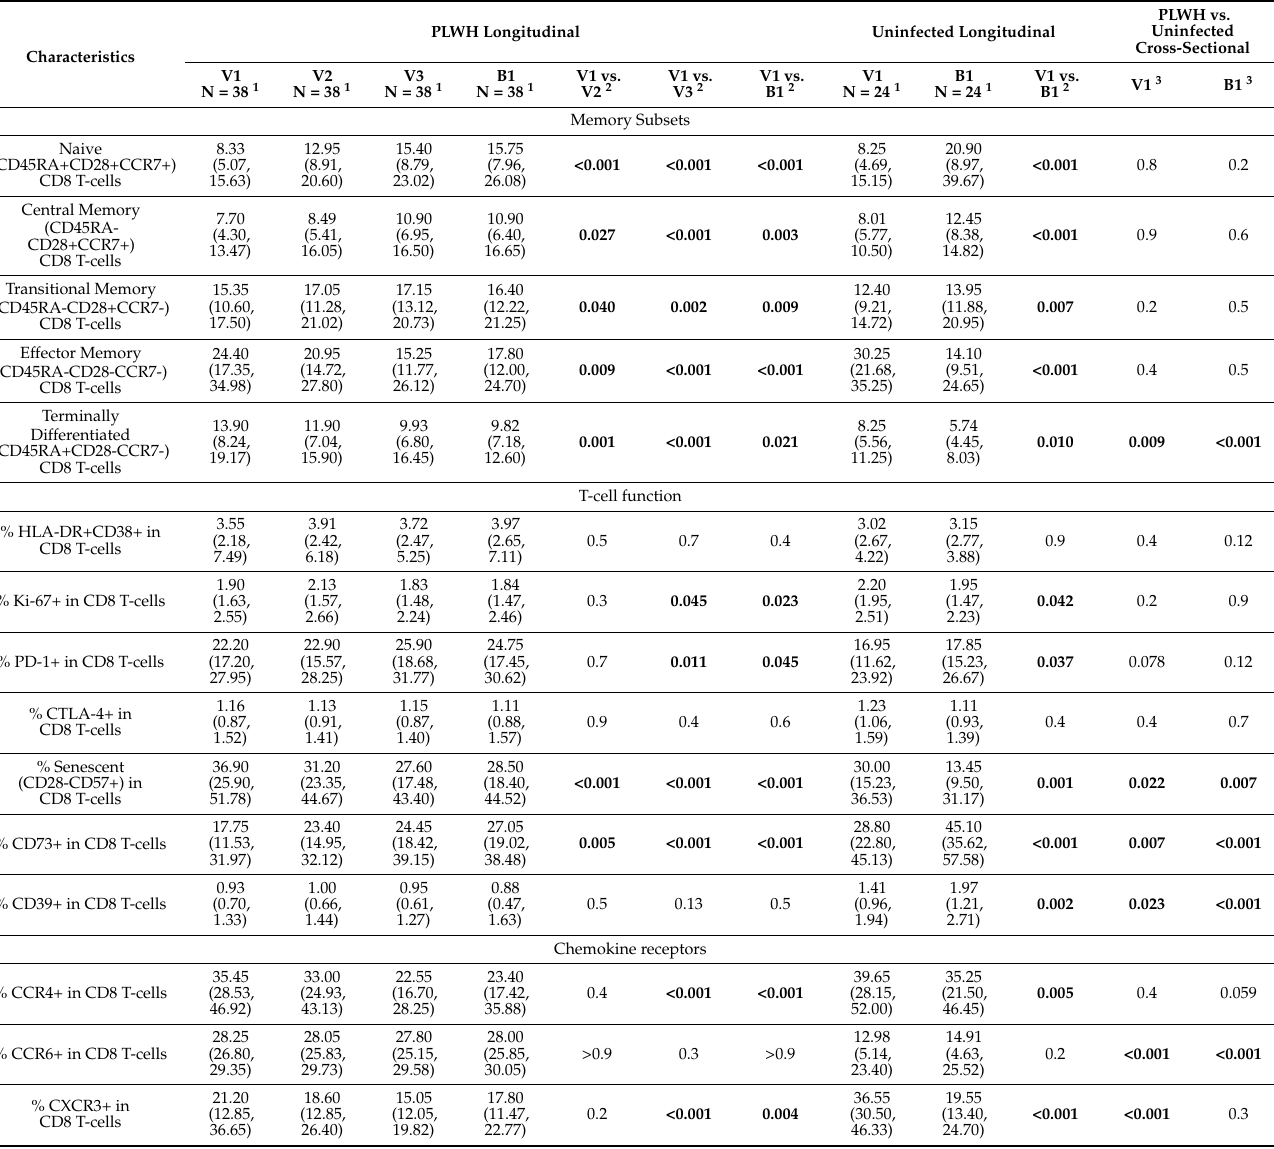
Table 3. Changes in the frequencies of CD8 T-cell subsets following SARS-CoV-2 vaccination in PLWH and uninfected controls. Results are presented as median (IQR) of the percentage (frequencies) within total alive CD8 T-cells. Study visits: V1—pre-vaccination baseline, V2—1 month post 1st dose, V3—3 months post 2nd dose, B1—1 month post 3rd dose. Significant differences ( p < 0.05) are highlighted in